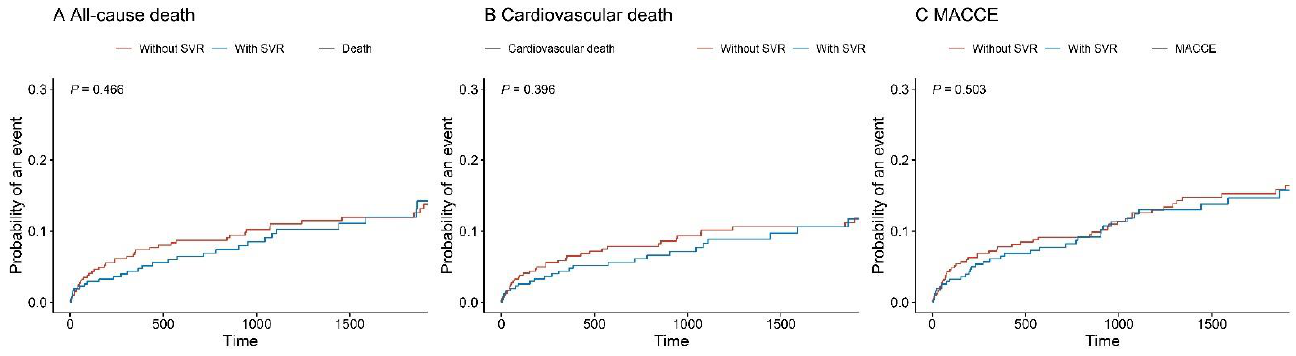
Figure 3. Time-to-event curves according to SVR group. CR = competing risk. MACCEs = major adverse cardiac and cerebrovascular events. ( A ) All-cause death; ( B ) Cardiovascular death; ( C ) MACCE.